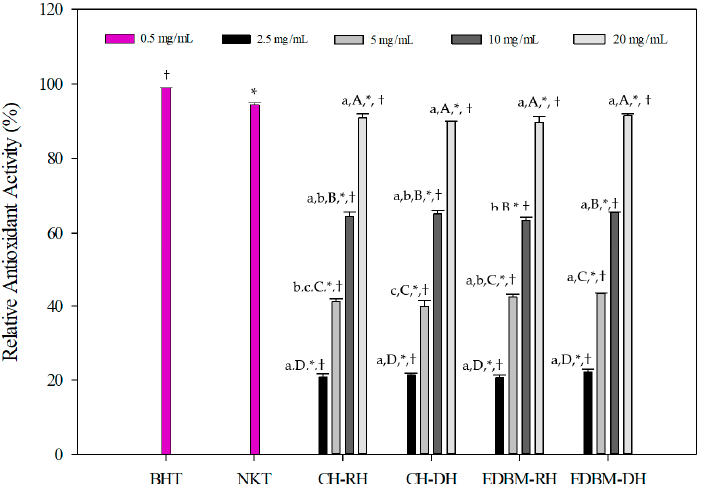
Figure 5. β‐ carotene bleaching inhibition activity of bovine hemoglobin hydrolysates at different concentrations in CH-RH, CH-DH, EDBM-RH and EDBM-DH. Values with (*) symbol are significantly different from BHT; values with (†) symbol are significantly different from neokyotorphin; values with different lowercase letters (a–c) within the same concentration are significantly different; values with different capital letters (A–D) within the same condition are significantly different ( p < 0.05, Tukey test).